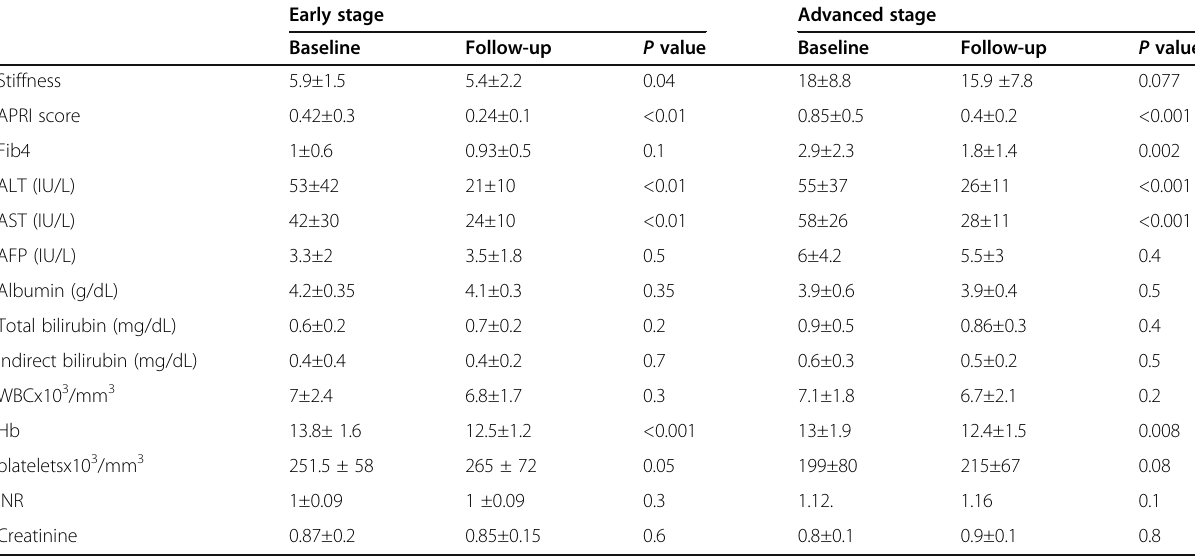
Table 3 Laboratory and fibrosis score changes in early and advanced groups Early stage Advanced stage